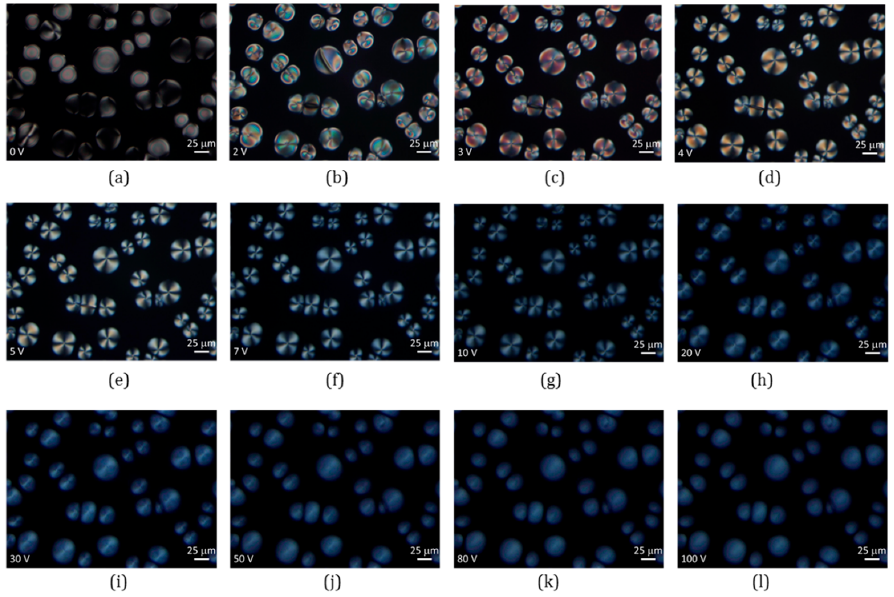
Figure 3. Images of the PDLC film with large droplets observed under POM with crossed polarizers at ( a ) 0, ( b ) 2, ( c ) 3, ( d ) 4, ( e ) 5, ( f ) 7, ( g ) 10, ( h ) 20, ( i ) 30, ( j ) 50, ( k ) 80, and ( l ) 100 V. Video S1 shows the corresponding time-lapse photograph of the PDLC film (one photo per second) at various voltages from 0 V to 100 V.